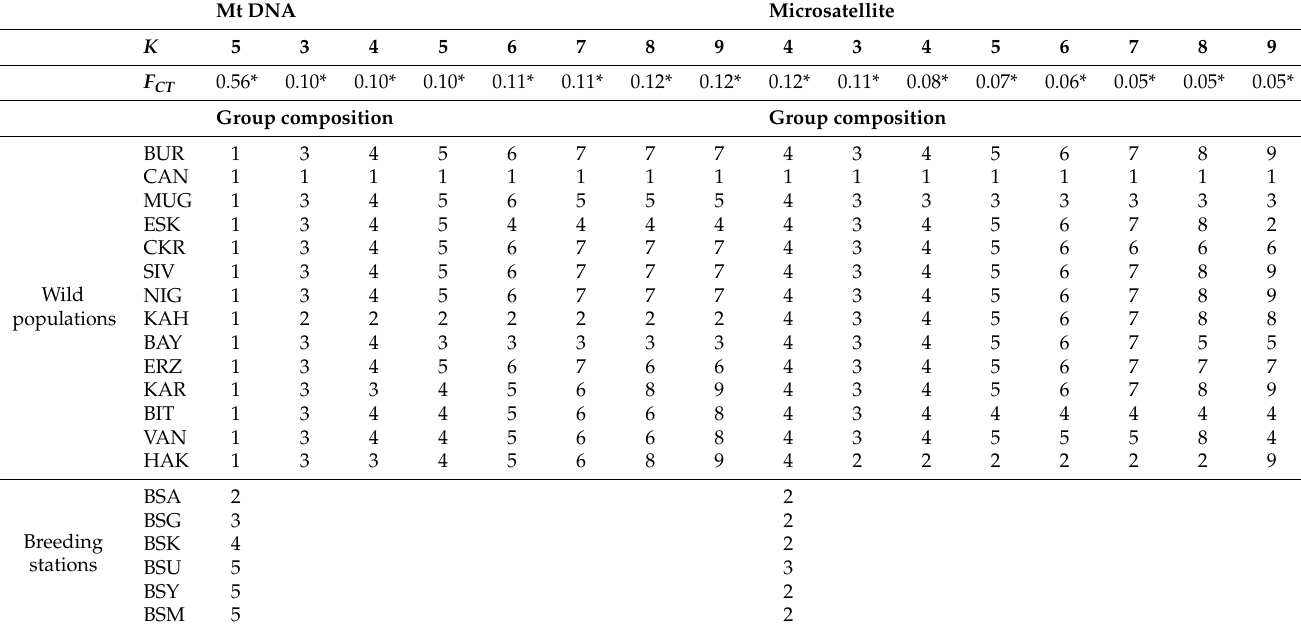
Figure 3. Population group defined in SAMOVA (six wild and four captive) based on mtDNA data. Circles represent geographic locations of wild populations and red angles represent the breeding stations on the map. Median-joining haplotype network constructed from the combined mt Cyt b and CR sequence data in Network 10. Haplotypes are represented by circles with size proportional to individual number. Mutational steps are shown by the number of hatch marks.